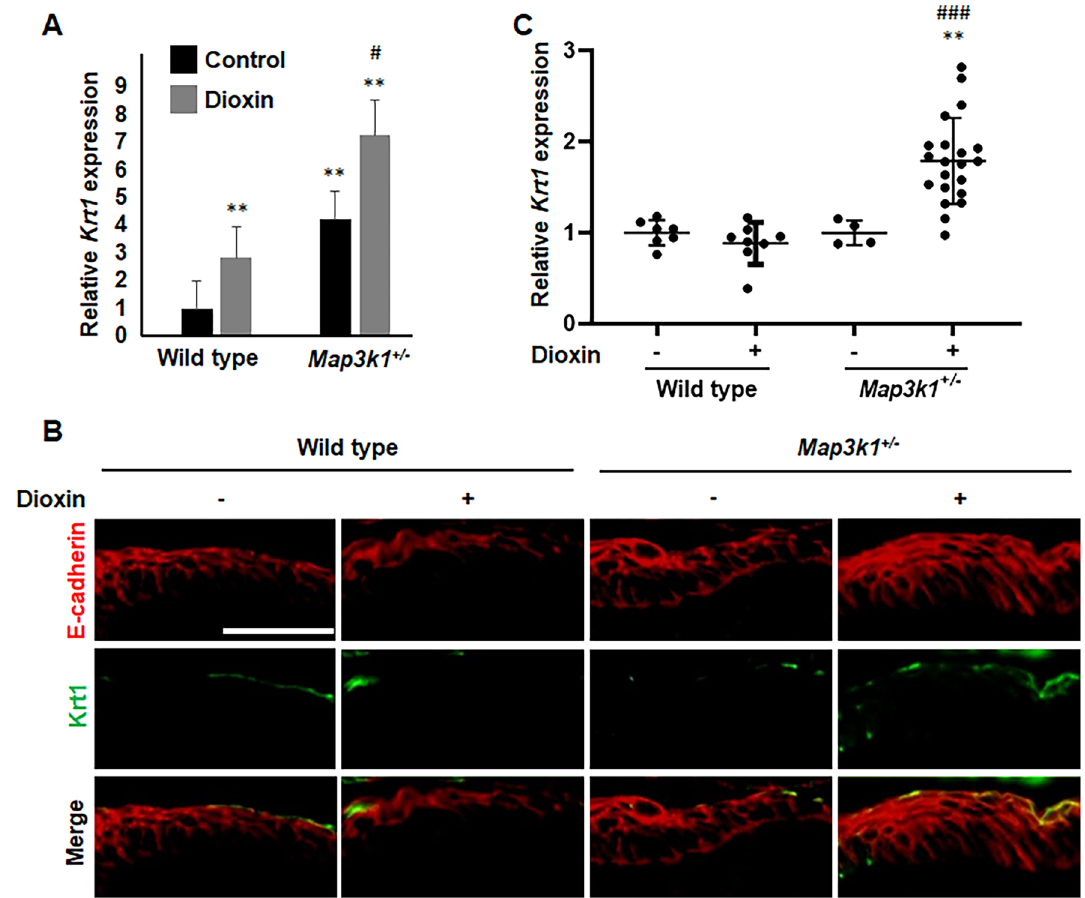
Figure 5. Dioxin plus Map3k1 loss-of-function potentiated keratinocyte terminal differentiation. The Krt 1 expression was examined (A) by RT-PCR in wild type and Map3k1 + /- D-KC with or without 10 nM dioxin treatment for 3 days, and ( B ) by immunohistochemistry in wild type and Map3k1 + /- E15.5 embryos with or without 50 ug/kg dioxin treatment at E11.5; E-cadherin labeled all epithelial cells. ( C ) Quantification of Krt 1-positive signals in ( B ). ** p < 0.01 are considered significantly different compared to wild type untreated samples, and # p < 0.05, ### p < 0.001 are considered significantly different compared to untreated samples of the same genotype. Scale bar represents 50